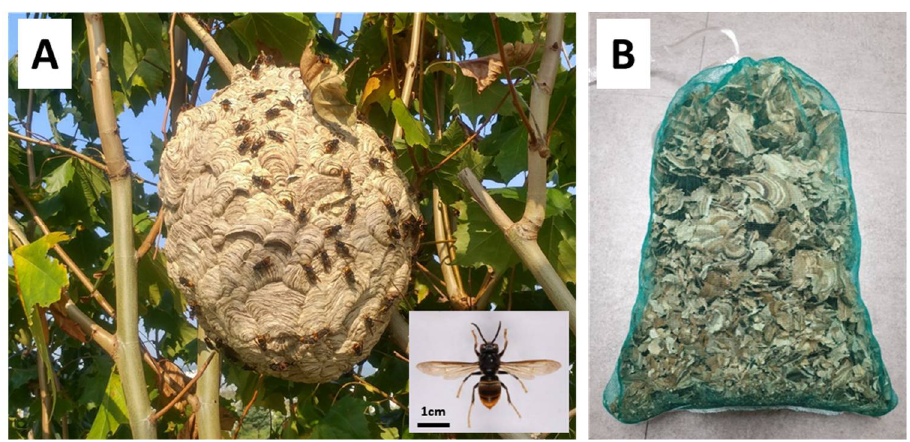
Figure 1. The Vespa velutina nigrithorax nest ( A ) and Nidus vespae extract materials ( B ). Nidus vespae was crushed into <1 cm long pellets. The pellets (836 g) were extracted with a solvent mixture (15 L) composed of dichloromethane and MeOH (1:1, v/v ) at room temperature (RT). The extract was filtered and concentrated under reduced pressure. The resultant crude extract (10.03 g) was suspended in MeOH (1 L), and the same volume of hexane was added. The sample was partitioned between the hexane (3.0 g) and MeOH layers using a separation funnel. The MeOH layer was concentrated under reduced pressure, and the obtained layer (6.27 g) was dissolved in distilled water (DW, 1 L). The DW suspension was extracted twice with ethyl acetate (EA, 1 L). Solvents were removed from the EA layer (1.66 g) under reduced pressure. The rest of the DW suspension was extracted twice with butanol (BuOH, 1 L). The solvent was evaporated under reduced pressure, and then the resultant extract was lyophilized to obtain powder (8.3 g).